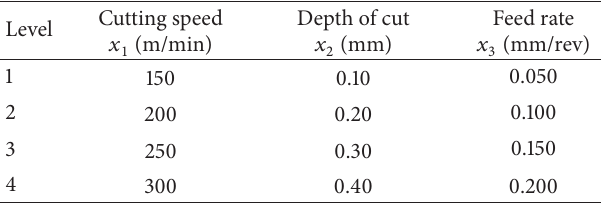
Table 4: Design variables values in four-level full-factorial matrix used as initial samples for m-EGO.